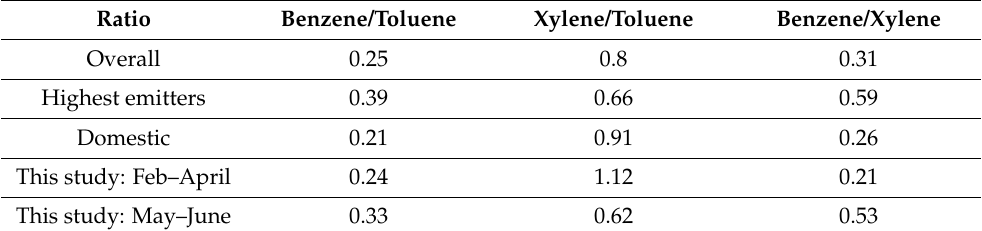
Table 8. Estimated ratios from the NSW emission inventory